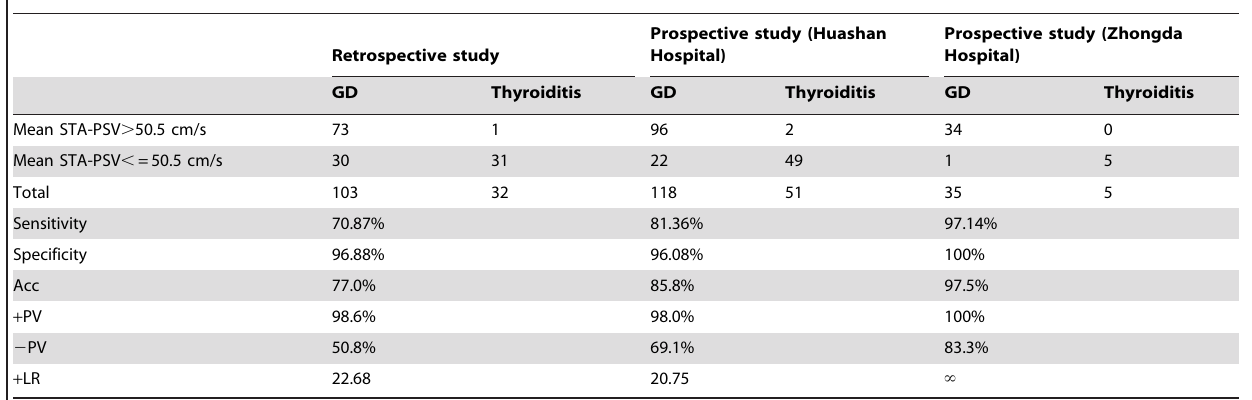
Table 2. Mean STA-PSV for the differential diagnosis of thyrotoxicosis.